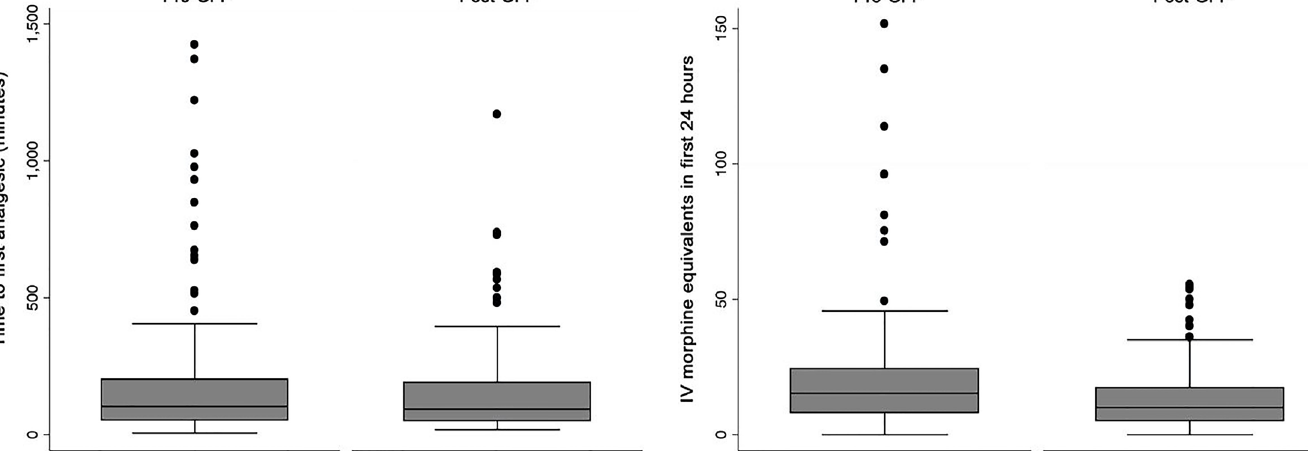
Figure 1. Time to first analgesic in minutes before and after implementation of a geriatric fracture program (GFP).